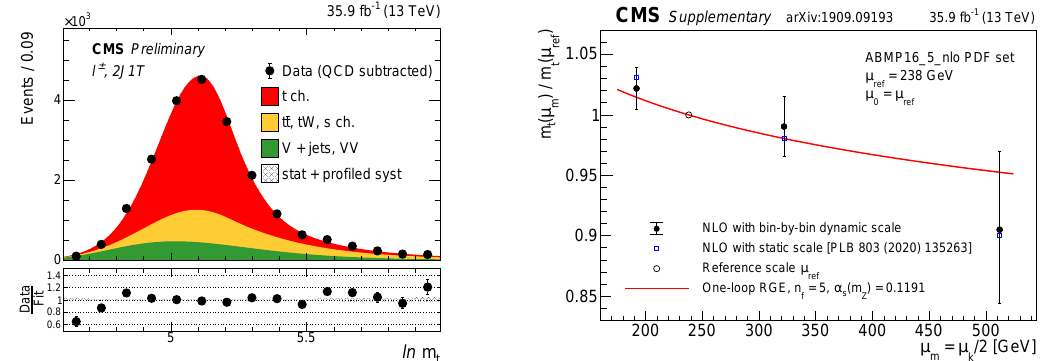
Figure 1: Reconstructed data as a function of the natural logarithm of the recon- structed top quark mass together with a functional fit (left) [ 4 ] . Measured scale de- pendence of the top quark mass as a function of the scale µ